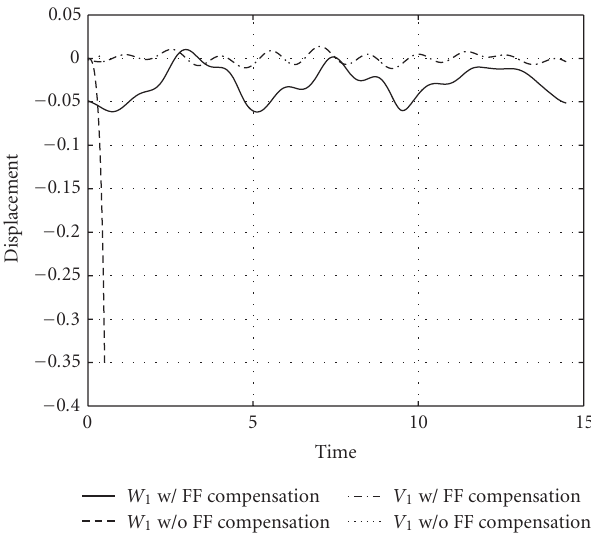
Figure 5: E ff ect of optimal FF controller for Ω b = 1 . 3.